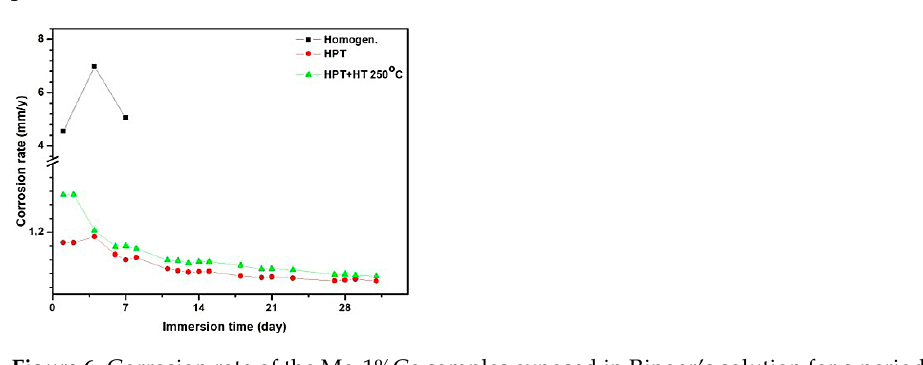
( b ) Figure 8. Structure of the Mg ‐ 1Zn ‐ 0.2Ca alloy after HPT processing: ( a ) bright ‐ field image; ( b ) dark ‐ field image showing dispersed particles. The microstructure of the Mg ‐ 1Zn ‐ 0.2Ca alloy after HPT processing and additional annealing at a temperature of 300 °C is presented in Figure 9, which reveals that the aver ‐ age grain size increased to 4 μ m, and the particle size increased to 70 nm. Analysis of the diffraction pattern obtained from a globular particle ([1 1(cid:3364) . 1(cid:3364) ] zone axis) confirms that this particle represents the Ca 2 Mg 6 Zn 3 phase with a hexagonal close ‐ packed (HCP) lattice (Fig ‐ ure 9c). The volume fraction of the second phase Ca 2 Mg 6 Zn 3 is about 1.5%. ( a ) ( b )